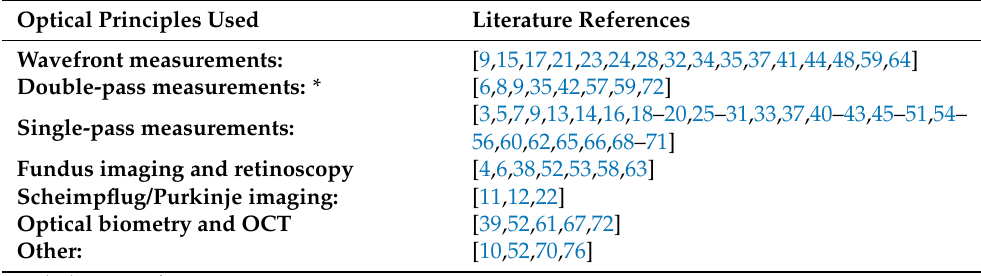
Table 3. Optical measurement modalities used on the devices included in this review, as reported by the respective publications. The purpose of such measurements could be either related to the main goal of the research study, or just for the optical characterization of the device, prior to its intended